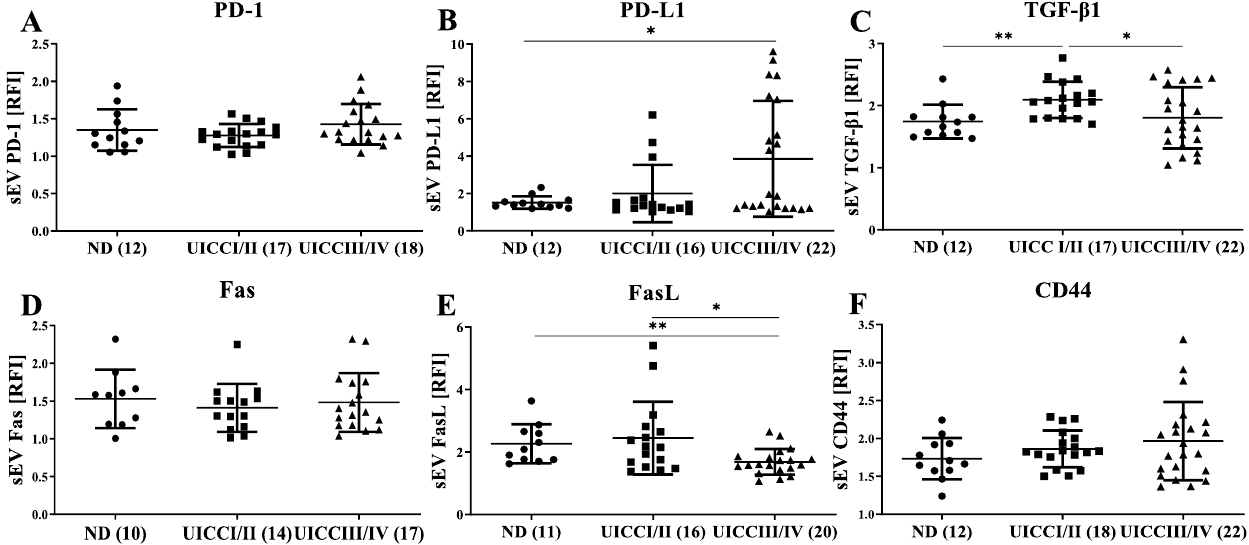
Figure 3. Altered expression of sEV immunosuppressive markers during tumor progression. CD63- coated streptavidin beads were used to capture sEVs from HNC patients and NDs. Captured sEVs were stained for various immunosuppressive markers. ( A , D , F ) PD-1, Fas and CD44 show similar expression on sEVs from HNC patients and NDs. ( B ) PD-L1 expression increases with tumor stages/tumor progression (UICC III/IV > I/II). ( C ) TGF- β1 is significantly overexpressed in early HNC stages (UICC I/II). ( E ) The FasL expression on exosomes decreases along with HNC tumor progression (UICC III/IV < I/II). A p -value below 0.05 was considered as significant (* p < 0.05, ** p < 0.01).